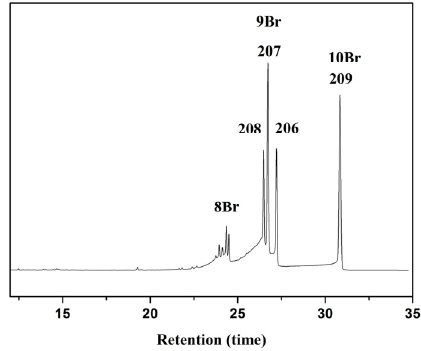
Figure 5. GC ‐μ ECD (gas chromatography paired with a microcell electron capture detector) GC- µ ECD (gas chromatography paired with a microcell electron capture detector) chromatograms of degradation products of BDE209 by 0.02 ‐ g ‐ C 3 N 4 ‐ TiO 2 in 2 h irradiation. chromatograms of degradation products of BDE209 by 0.02-g-C 3 N 4 -TiO 2 in 2 h